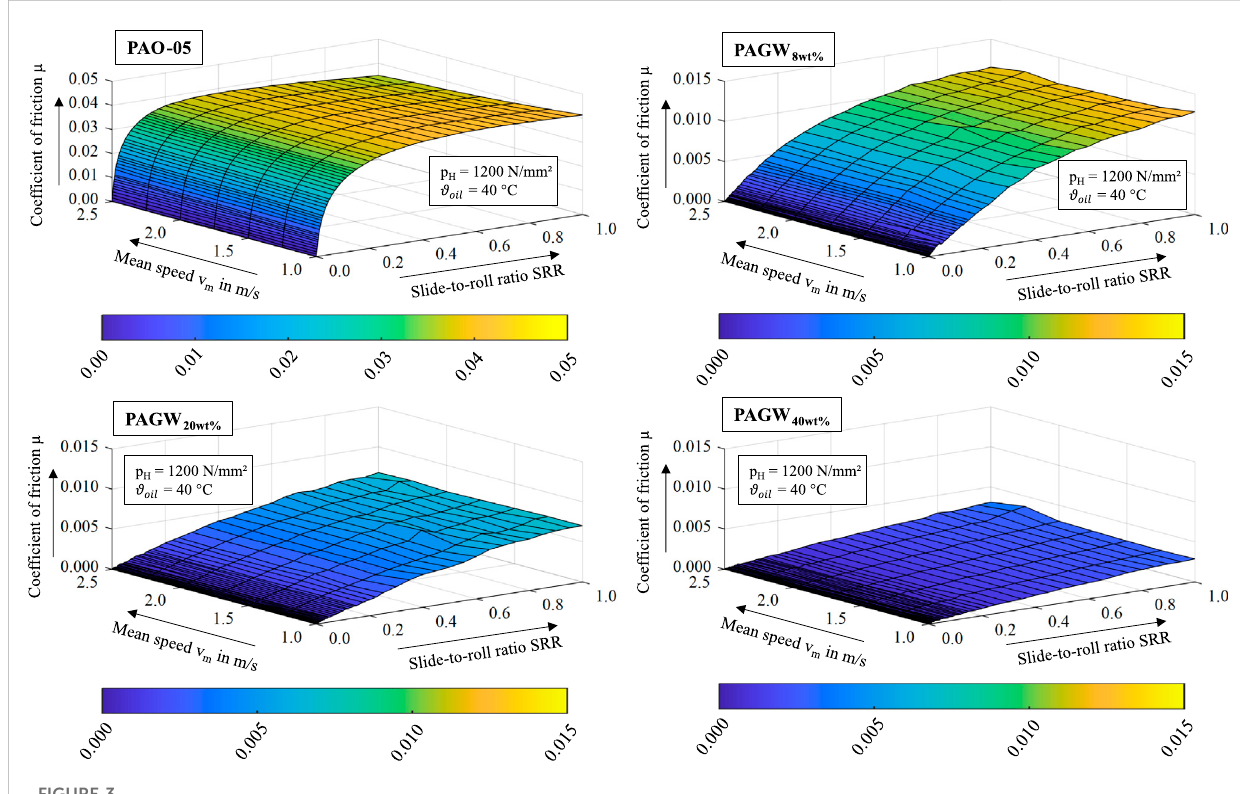
FIGURE 3 Friction maps in comparison of the investigated lubricants at p H = 1200 N/mm 2 and ϑ Oil = 40 °